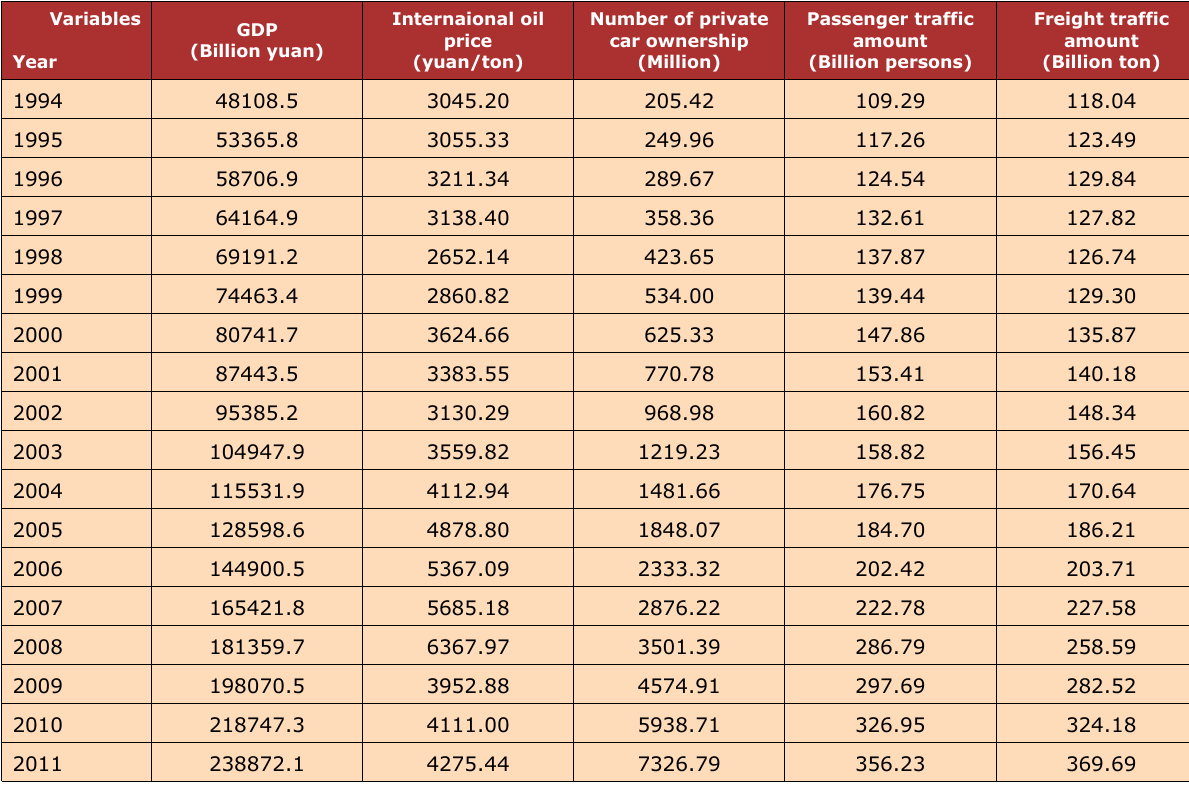
Table 3. Historical Data of Carbon Emission Impact